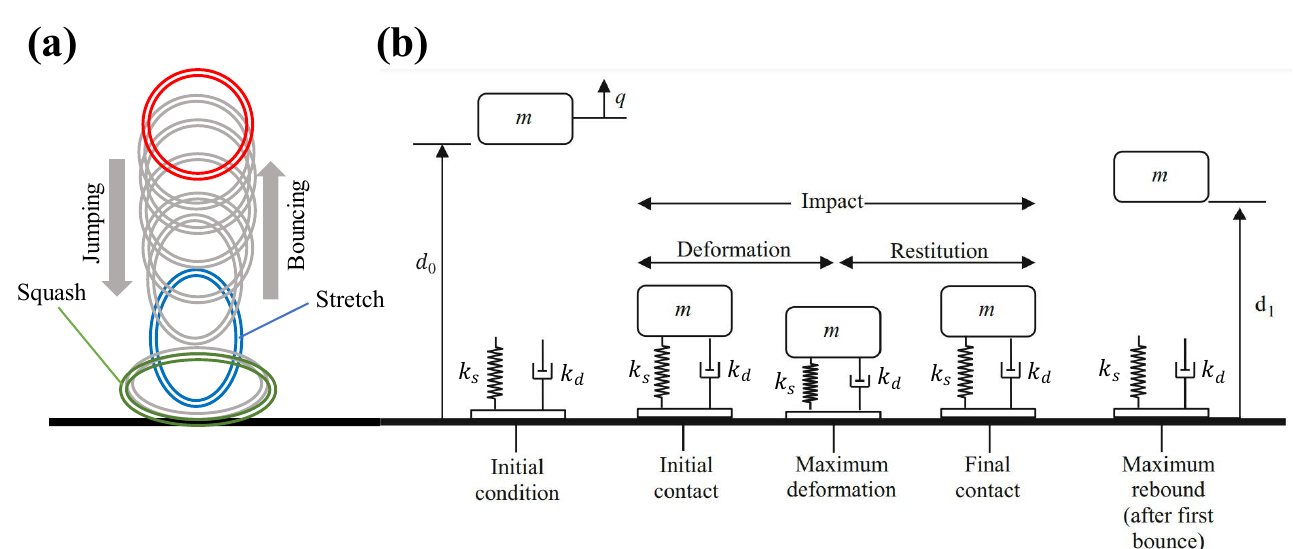
Figure 8. ( a ). Schematic representation of the deformation mechanism of bounding stretchable ball (a cross-section of the ball is shown); ( b ) A mass-spring-damper model of a bouncing ball showing phases of the first cycle (figure adapted and licensed from [42]).